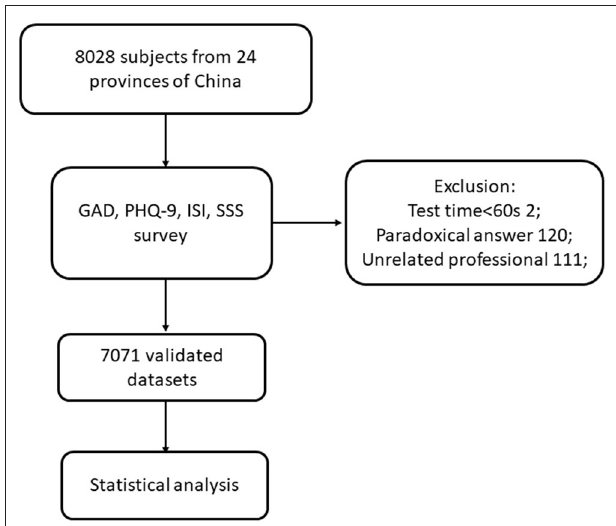
FIGURE 1 | Cohort